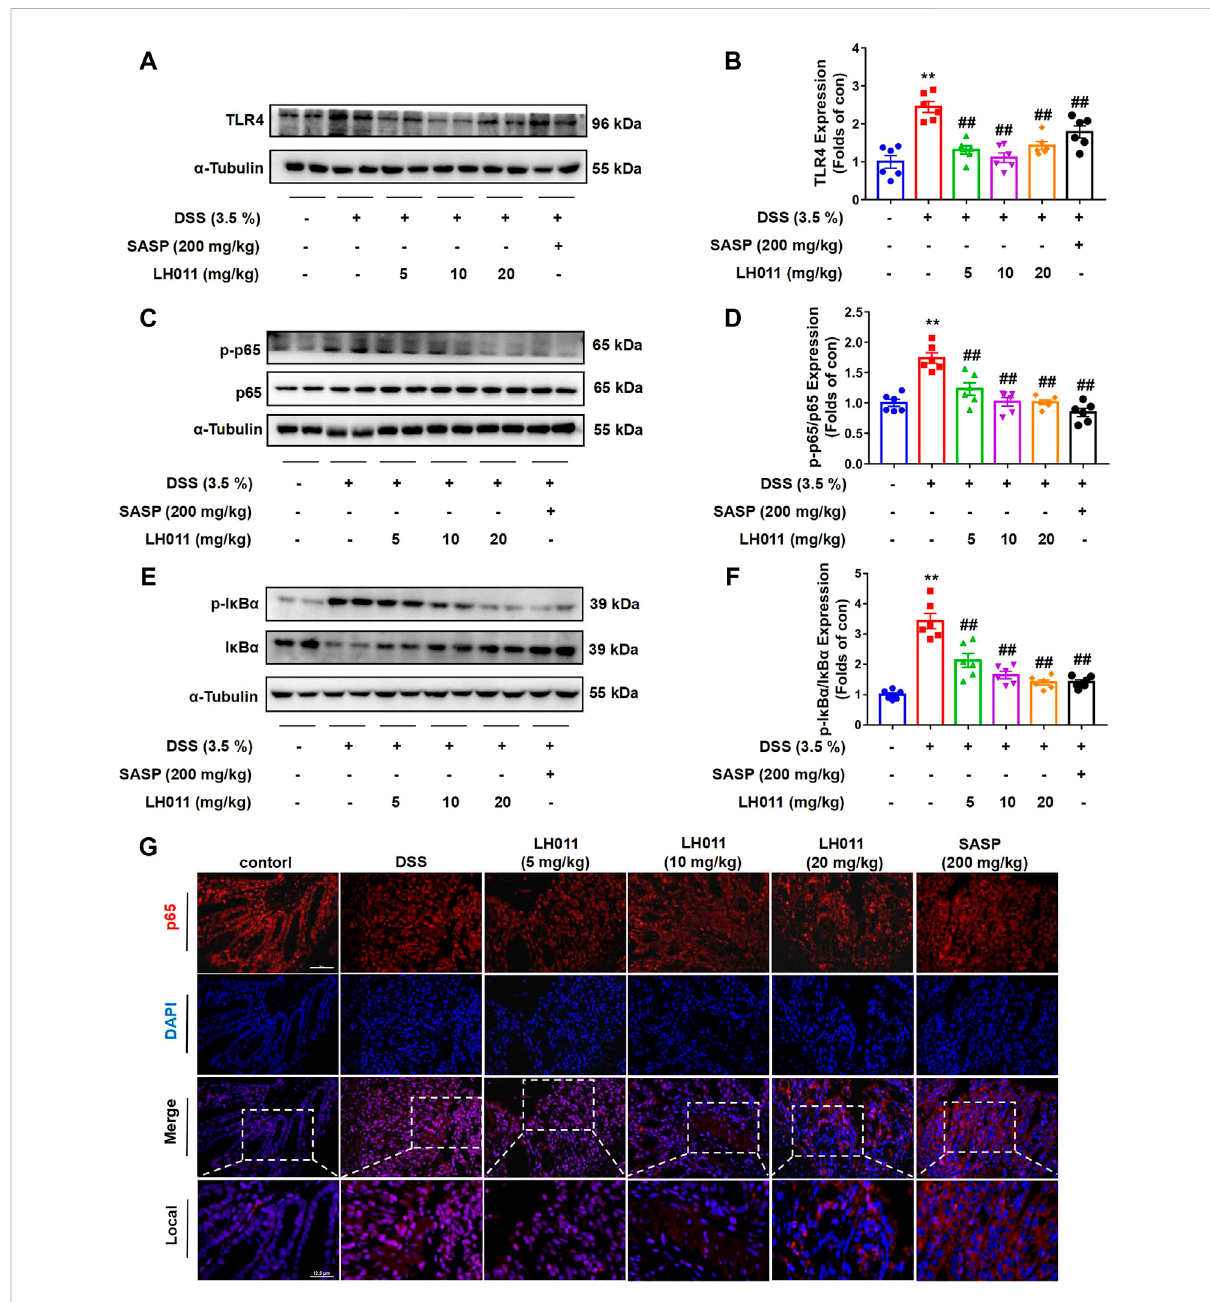
FIGURE 4 LH011 relieved in fl ammation by inhibiting TLR4/NF- κ B signaling pathway in DSS-induced colitis mice. (A – F) Protein levels of TLR4, phosphorylated NF- κ B p65, total p65, phosphorylated I κ B α , and total I κ B α in colonic tissue were measured by Western blot. n = 6. (G) Immuno fl uorescence results to indicate the sub-localization of NF- κ B p65, scale bar: 50 μ m, n = 3. All data are presented as the mean ± SEM. ** p < 0.01 vs. control group; ## p < 0.01 vs. DSS